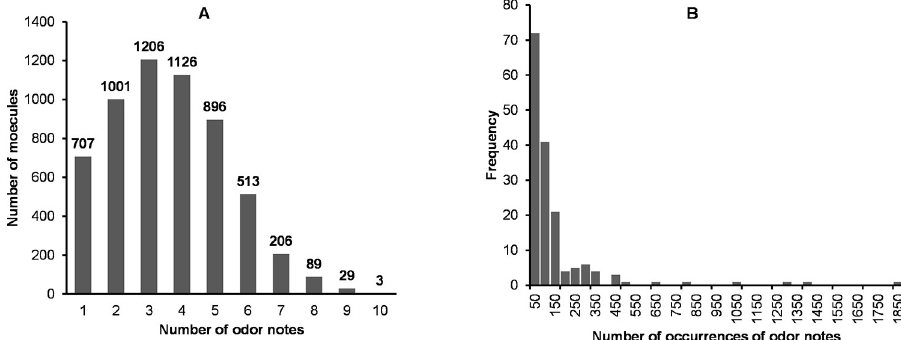
Fig 2. Distribution of the odor notes and the number of their occurrences. A: Histogram of the number of odorants according to the number of odor notes. B: Histogram of the workforce according to the number of occurrences of the